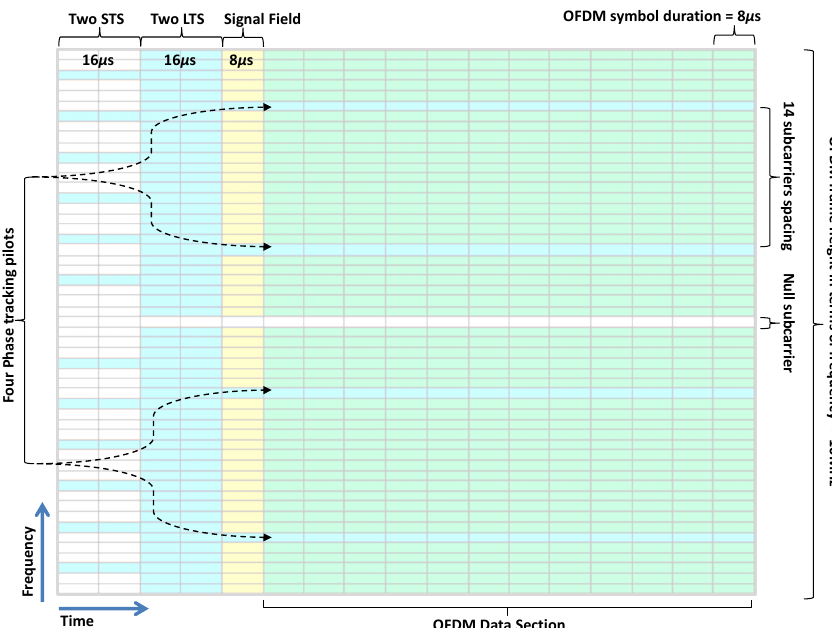
Figure 1. Orthogonal frequency division multiplexing (OFDM) frame format of the IEEE